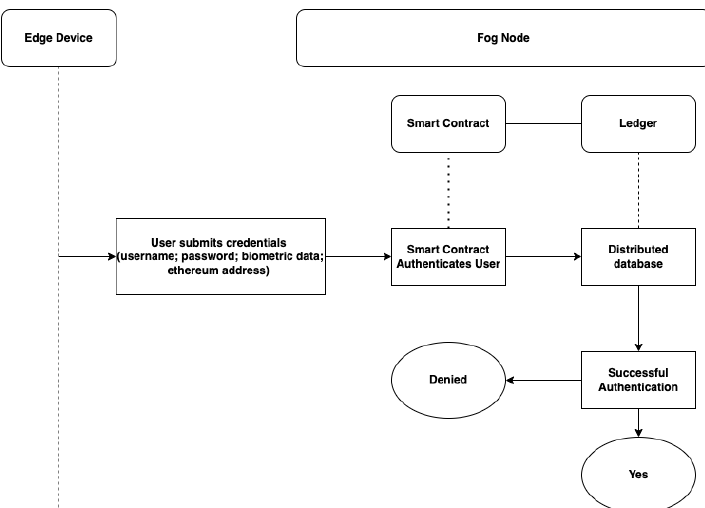
Figure 3. Flow diagram for user